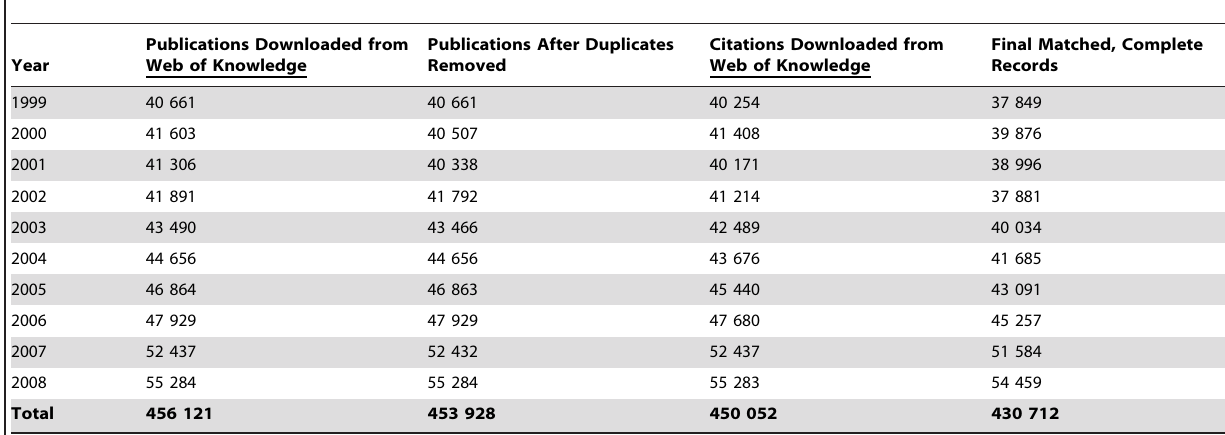
Table 1. Trends in publications (integer count) and citations downloaded from Web of Knowledge by year using the cardiovascular bibliometric filter.